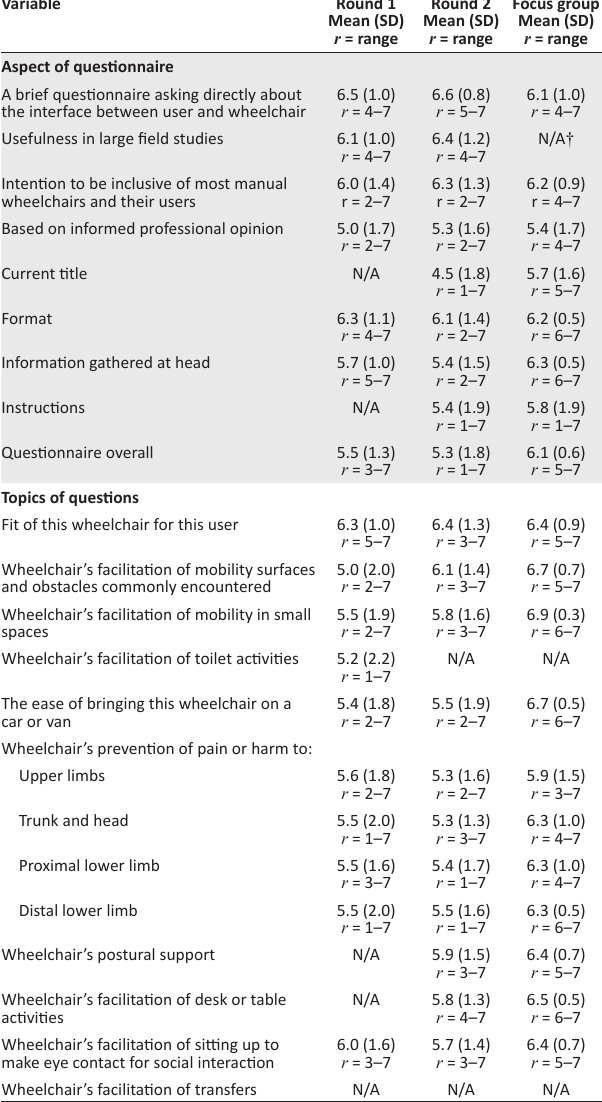
TABLE 2: Mean Likert scores from Delphi Round 1, Round 2 and focus group.